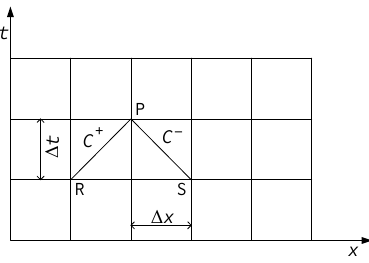
Figure 3. Water hammer characteristic lines in the x – t coordinate system.